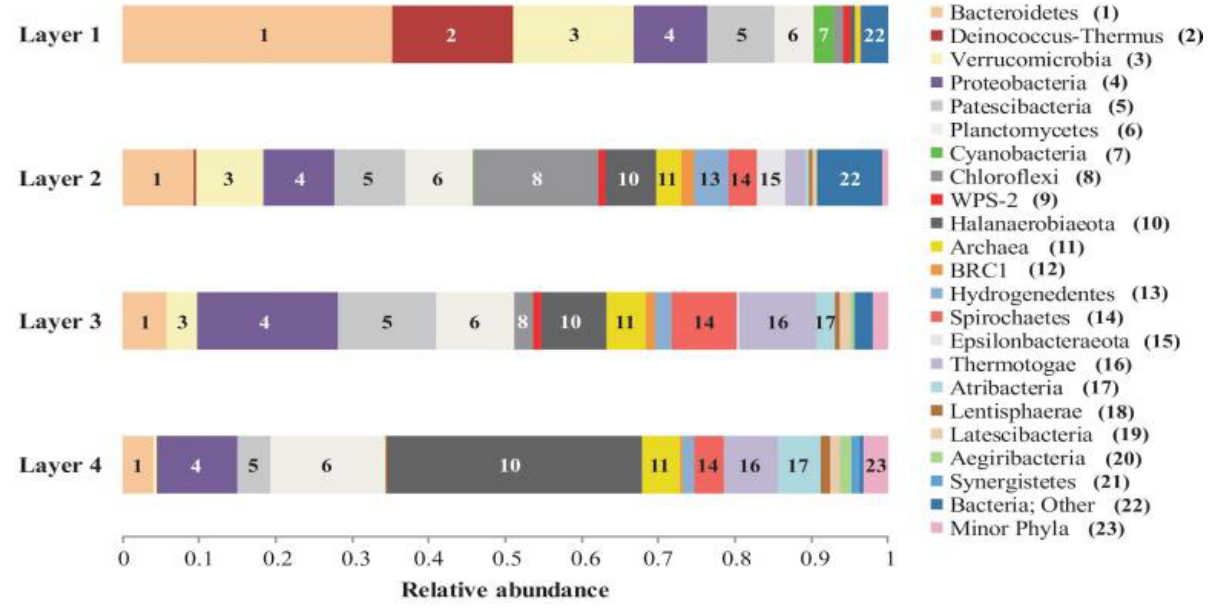
Figure 4. Relative abundance of bacterial phyla and Archaea in the Laguna Negra microbial mat layers. Assignations are derived from sequences analysis of the V4 hypervariable region of 16S rRNA gene. “Minor phyla” indicates less than 1% of abundance and included Acetothermia, Aci- dobacteria, Chlamydiae, Cloacimonetes, Firmicutes, Fusobacteria, Marinimicrobia (SAR406 clade), Omnitrophicaeota, and WS1. “Bacteria; Other” indicates